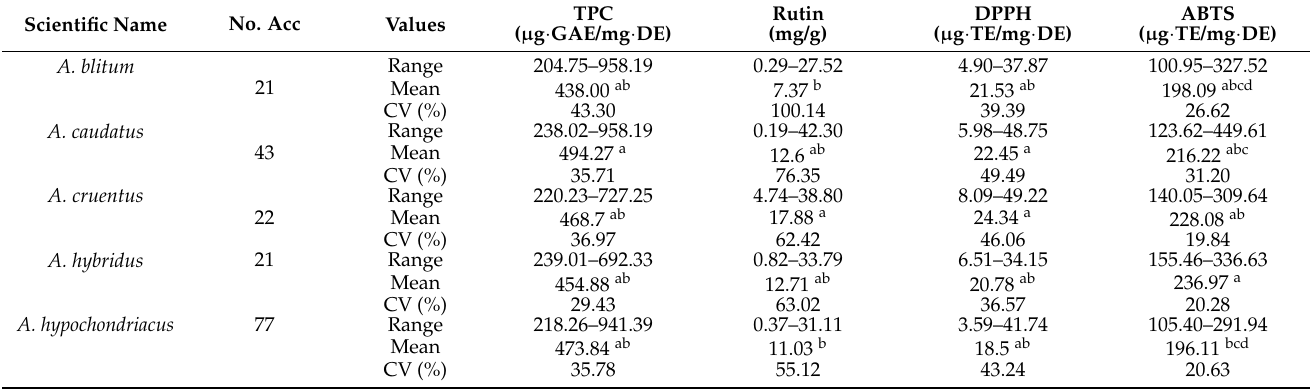
Table 3. Comparison of the total phenolic content (TPC), rutin content, and DPPH and ABTS antioxidant activities of nine Amaranthus